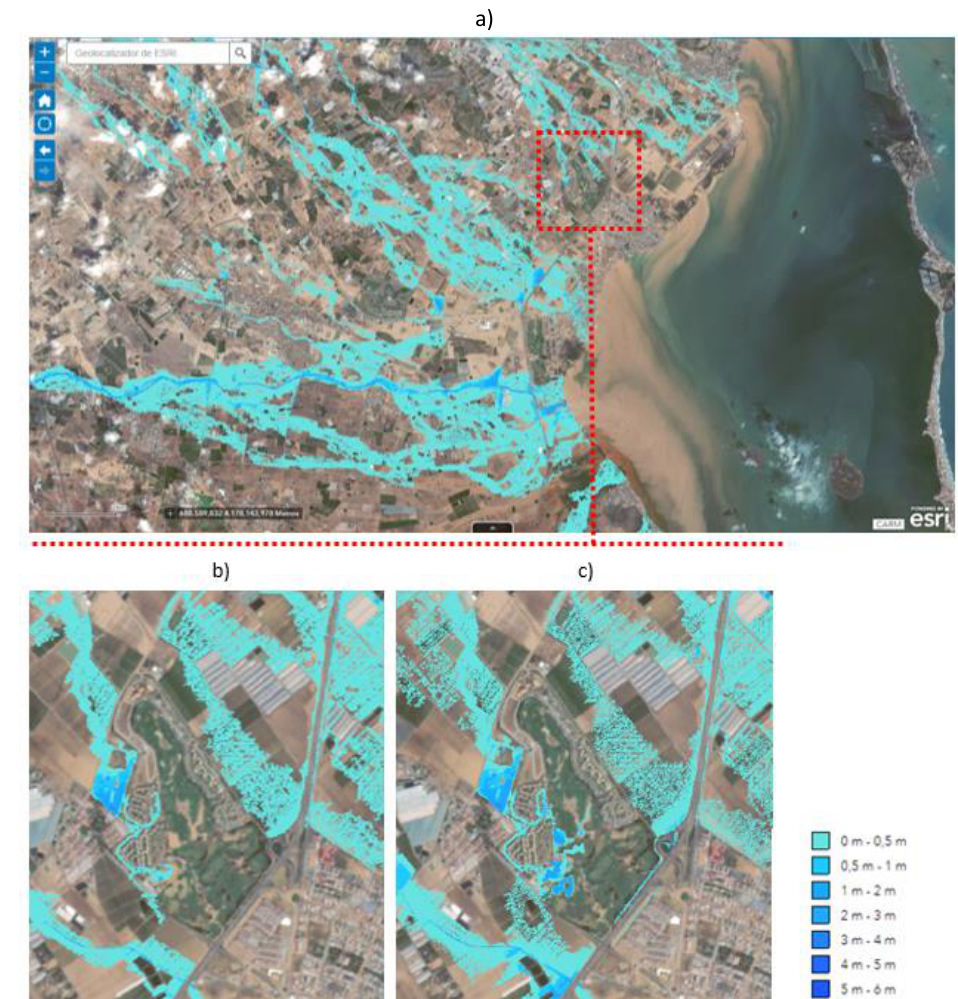
Figure 10. ( a ) Overlapping of the simulated drafts through the flow network of the existing theoretical model in the wa- tershed and the flow network observed in the DANA of 09/13/2019 (above). Detail of said contrast for a theoretical simu- retical model in the watershed and the flow network observed in the DANA of 13 September 2019 lation with ( b ) T = 100 years (bottom left) and ( c ) T = 500 years (bottom right). Data sources: National Floodplain Cartog- (above). Detail of said contrast for a theoretical simulation with ( b ) T = 100 years (bottom left) and raphy System (Ministry of the Environment of Spain, [42]) and Sentinel 2 satellite. ( c ) T = 500 years (bottom right). Data sources: National Floodplain Cartography System (Ministry of the Environment of Spain, [42]) and Sentinel 2